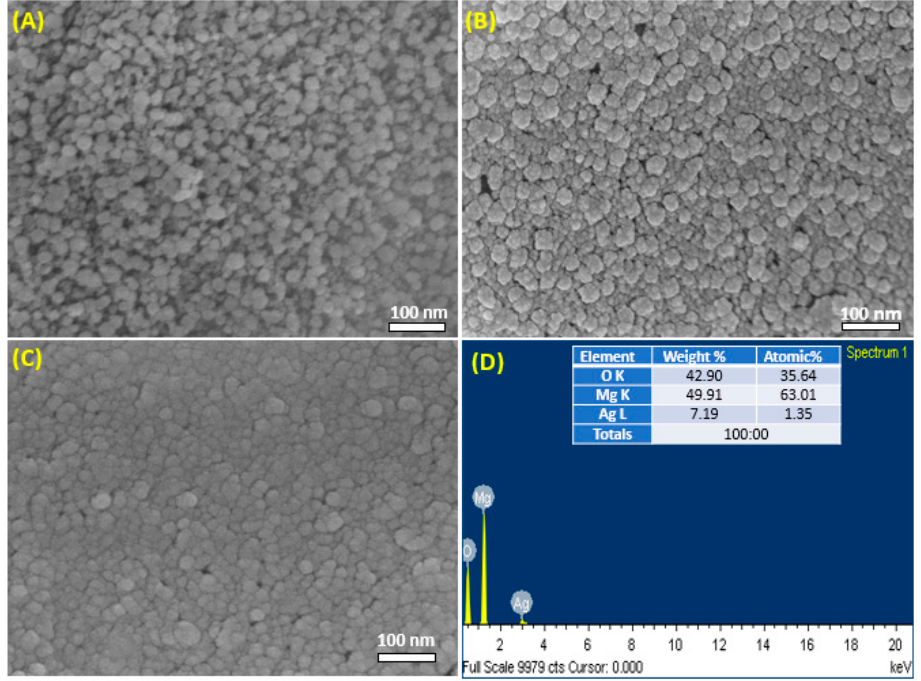
Figure 4. SEM images of pure ( A ), 1% Ag ‐ MgO ( B ), and 7.5%Ag ‐ MgO ( C ). EDX spectra of 7.5% Ag ‐ MgO NPs ( D ).